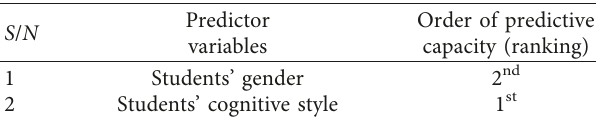
Table 4: Relative contribution of independent variables on stu- dents’ achievement in summary writing.